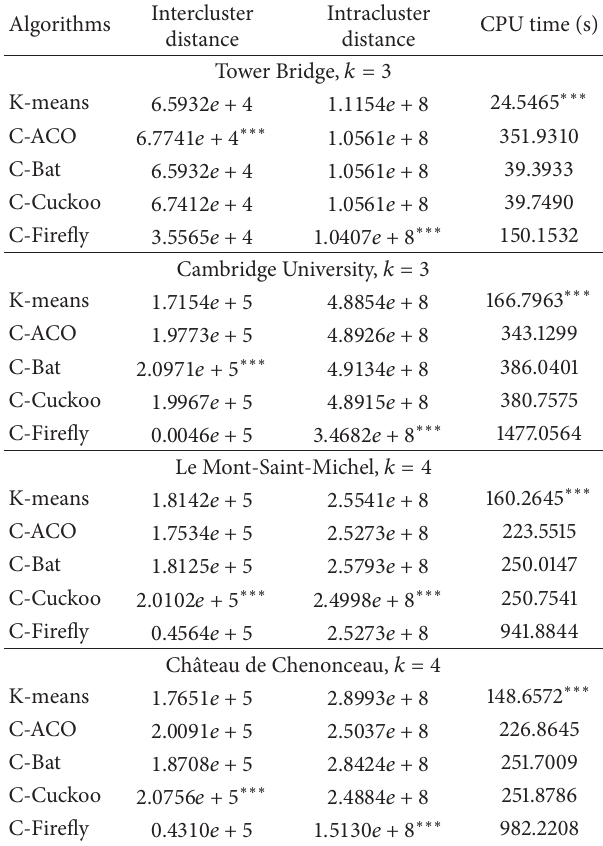
Table 13: Accuracy of clustering in the three datasets using different clustering algorithms.